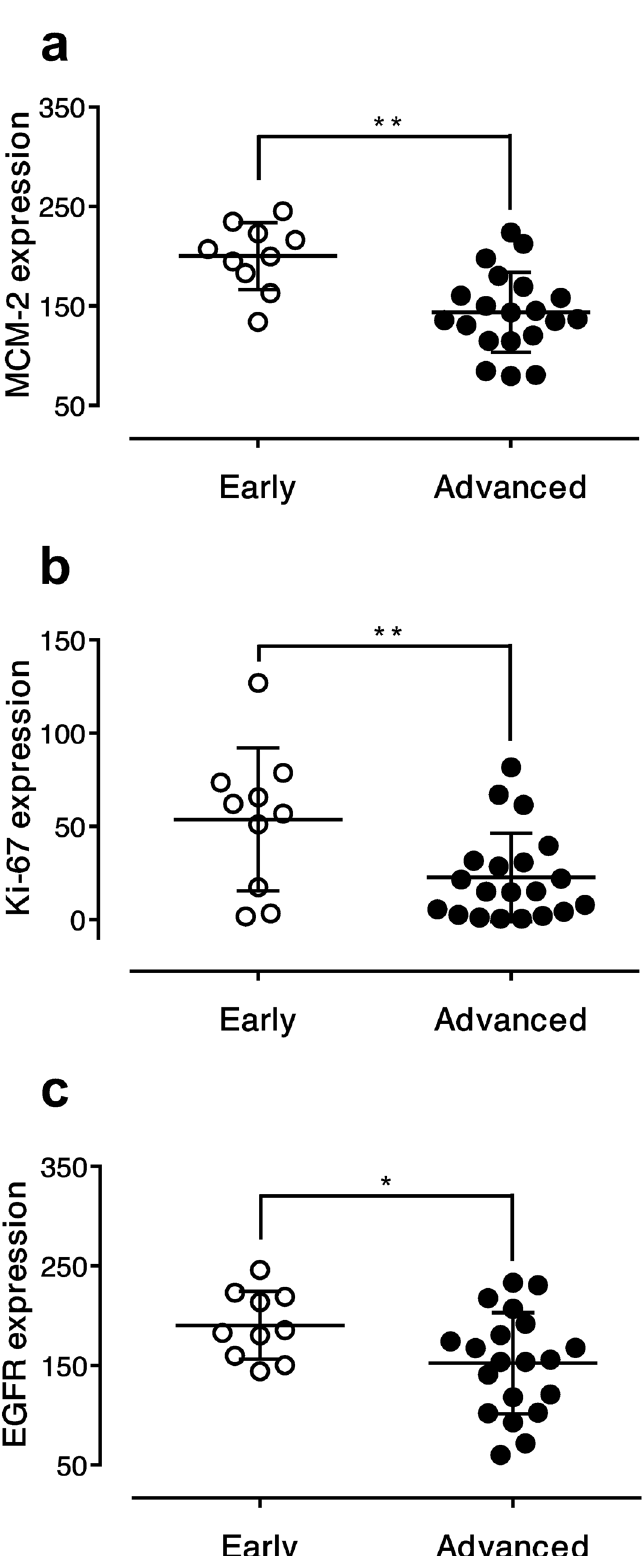
Figure 2. Significant downregulation of the mean expression levels of ( a ) MCM-2, ( b ) Ki-67, and ( c ) EGFR in advanced-stage disease in 30 LSCC patients. Data are presented as the mean ± SD. * p < 0.05, ** p <